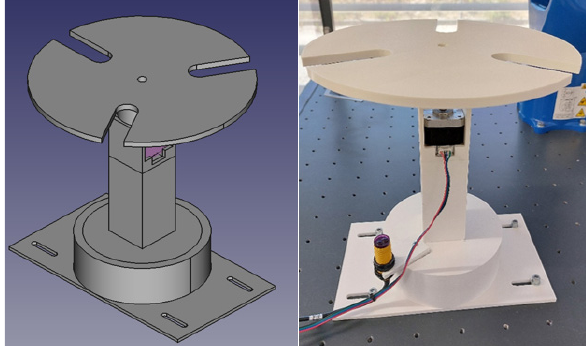
Figure 3. Rotary table and its model. Source: (Own).